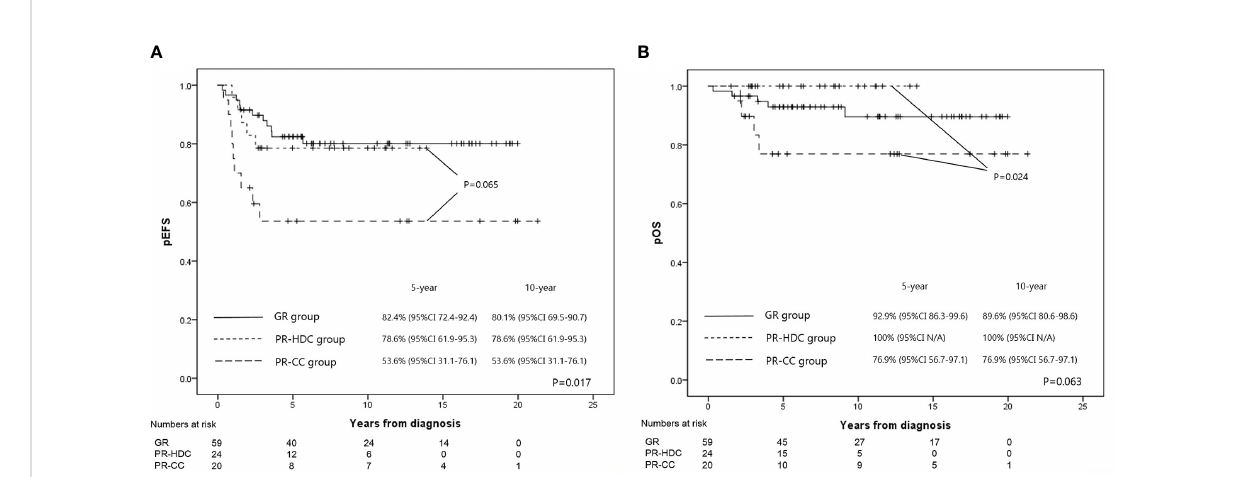
FIGURE 3 The EFS rates (A) and OS rates (B) at 5 years for GR, PR-HDC, and PR-CC groups were 82.4% versus 78.6% versus 53.6% (P=0.017), and 89.6% versus 100% versus 76.9% (P=0.063),